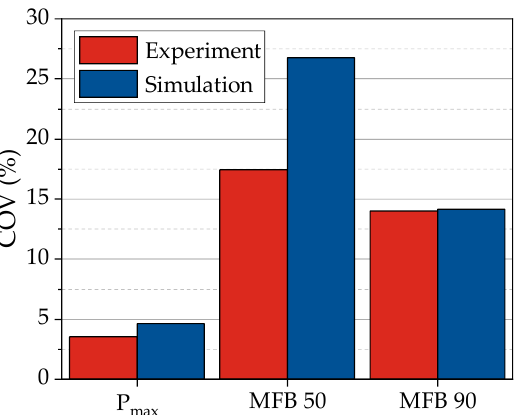
Figure 4. COV of peak pressure, 50% mass fraction burnt and 90% mass fraction burnt, derived from the simulated and the experimentally determined pressure traces.